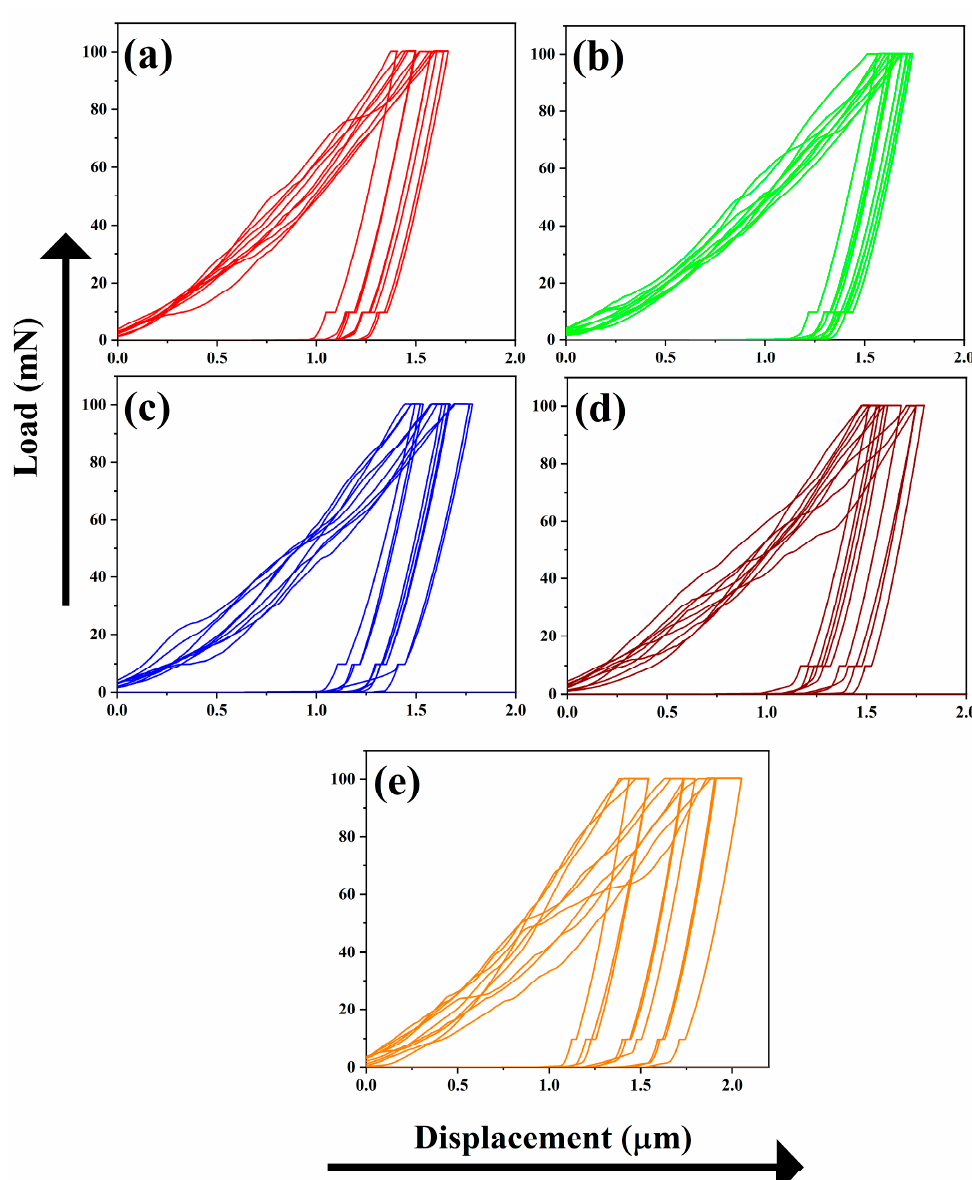
Figure 7. Nanoindentation test representing the five different β -Ca 3 (PO 4 ) 2 –ZrO 2 composites sintered at 1100 °C . ( a ) 1CPZ, ( b ) 2CPZ, ( c ) 3CPZ, ( d ) 4CPZ, and ( e ) 5CPZ. at 1100 ◦ C. ( a ) 1CPZ, ( b ) 2CPZ, ( c ) 3CPZ, ( d ) 4CPZ, and ( e )